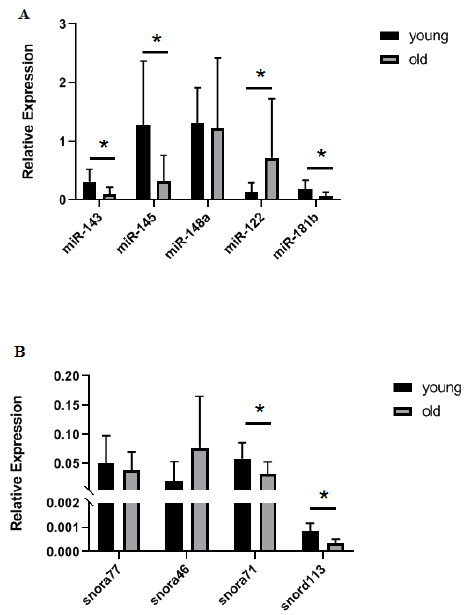
Figure 4. Validation of selected sncRNAs in an extended cohort of equine young and old chondrocytes. Real-time quantitative Polymerase Chain Reaction (qRT-PCR) was used to validate findings from the small RNA sequencing ( A ) microRNAs and ( B ) snoRNAs , n = 5–12 per group. Statistical analysis was with * denoting p <